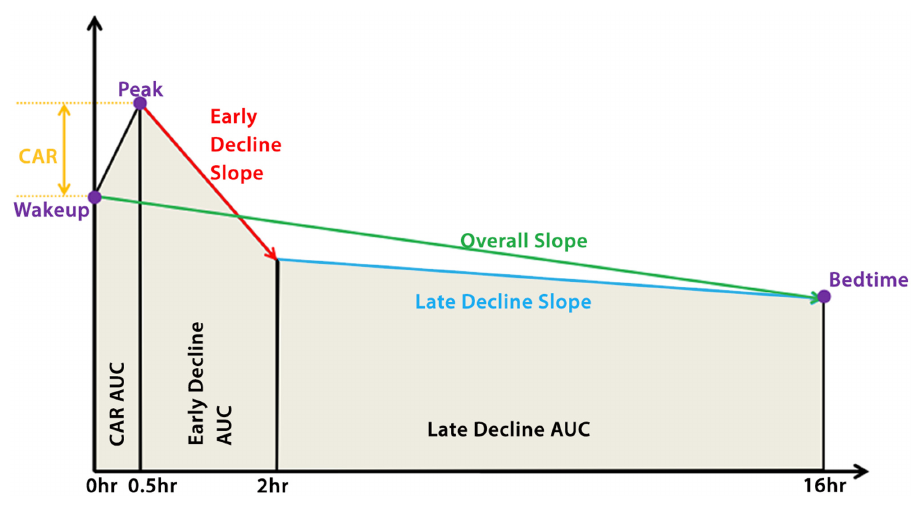
Fig 1. Representation of the diurnal cortisol curve describing our summary features of interest. In our study we specifically used Wakeup, Bedtime, Cortisol awakening response (CAR), Area under the curve (AUC) from 0 – 16 hours, Early Decline Slope, Late Decline Slope, and Overall Decline